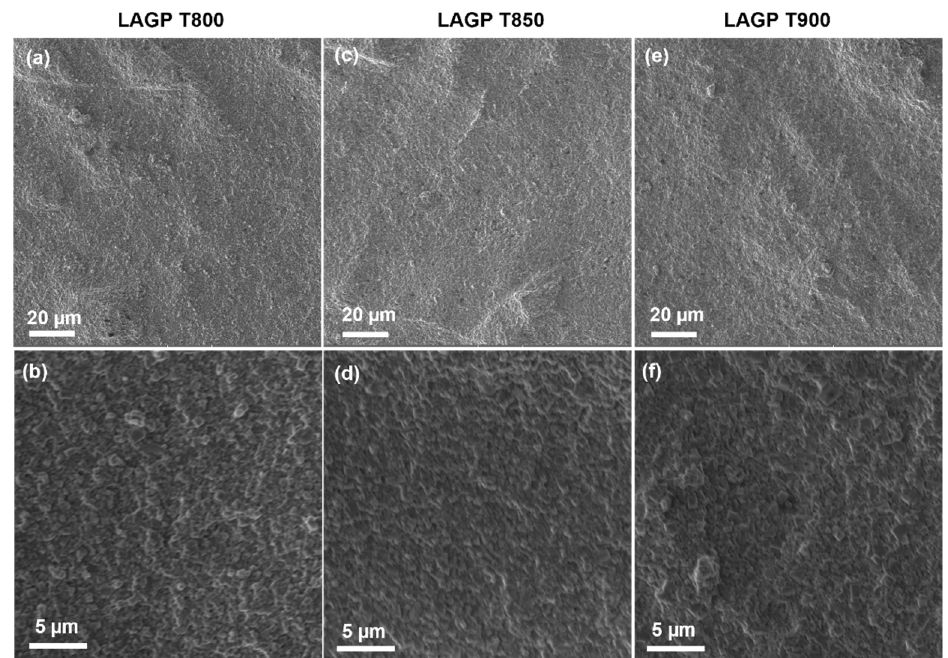
Figure 1. SEM images of LAGP pellets sintered at ( a , b ) 800 °C, ( c , d ) 850 °C, and ( e , f ) 900 °C. XRD patterns of LAGP pellets sintered at 800–900 °C are shown in Figure 2a. All the characteristic peaks of LAGP pellets match well with the LAGP powders and can be in- dexed as LiGe 2 (PO 4 ) 3 (JCPDS PDF No. 80-1924). Figure 2b gives the Nyquist plot of LAGP